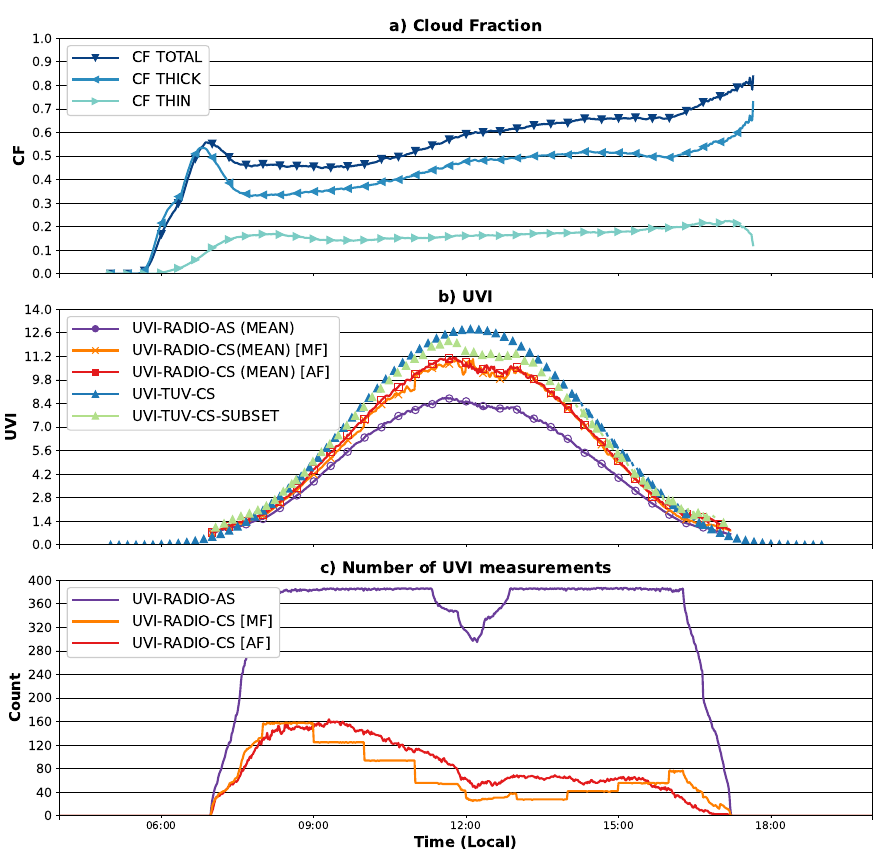
Figure 4. Mean diurnal cycle of cloud fraction and UVI. ( a ) Total, thick, and thin cloud fraction. ( b ) Mean UVI in all sky (purple circle). ( c ) Number of UVI